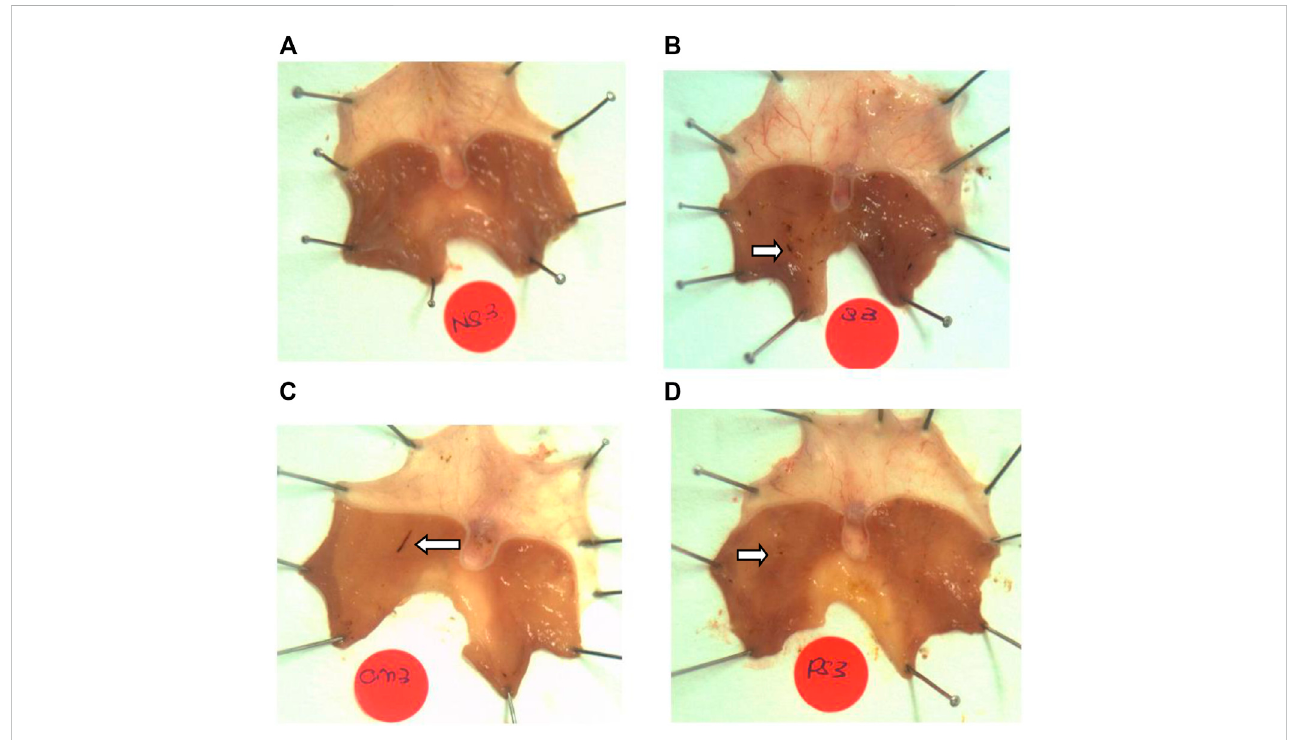
FIGURE 1 Macroscopic observation of gastric lesions in (A) normal rats(no lesions), (B) rats exposedto WIRSfor 3.5 h(developedlesions), (C) omeprazole-treated, and (D) P. sarmentosum -treated. Arrows indicate gastric lesions.